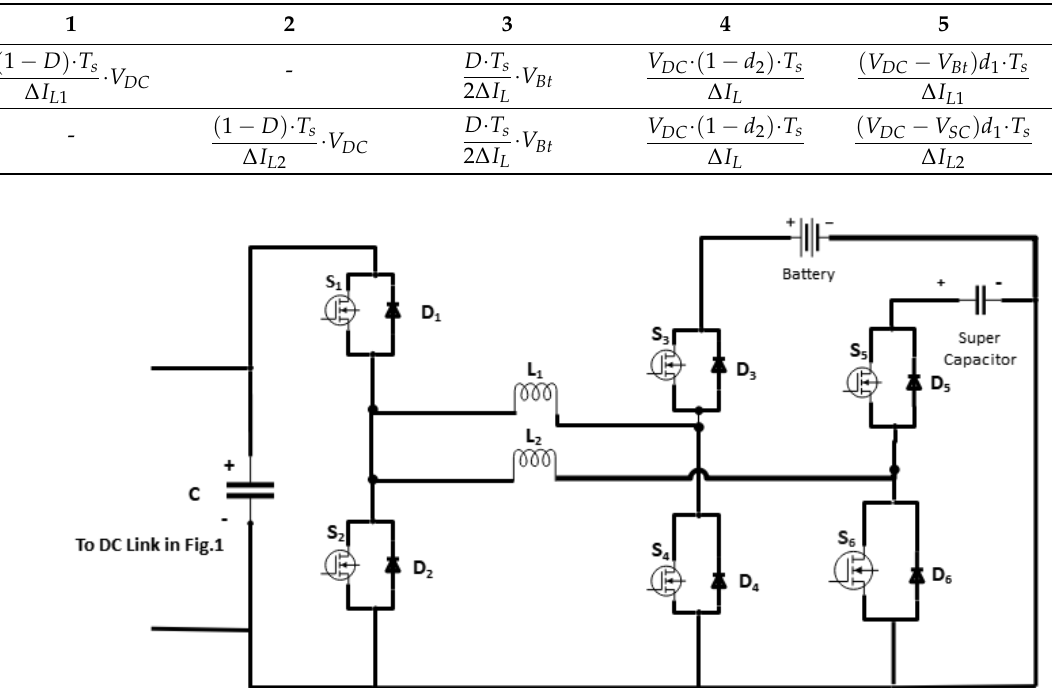
Figure 1. The configuration of the fast-charging station of electric vehicles. Table 2. Inductance equations for different operation modes. Table 2. Inductance equations for different operation modes.